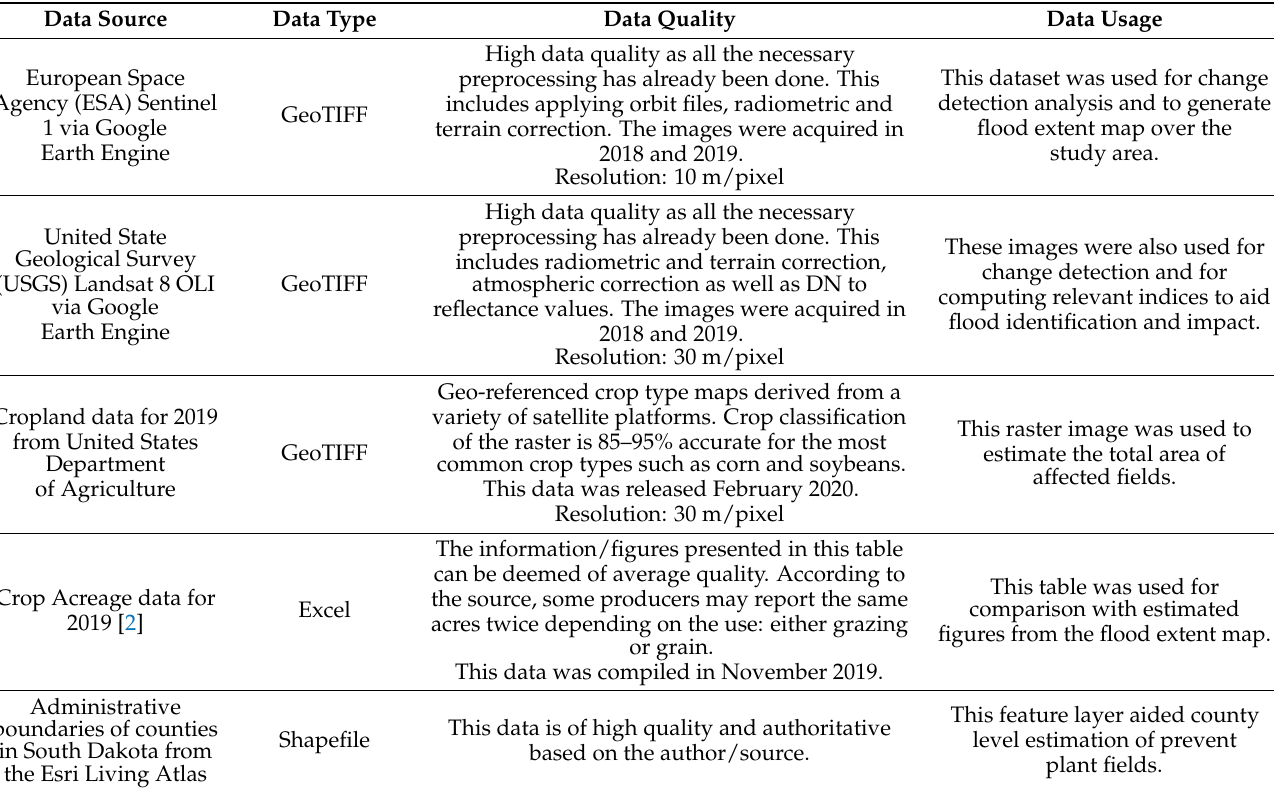
Table 1. Summary of the data used.